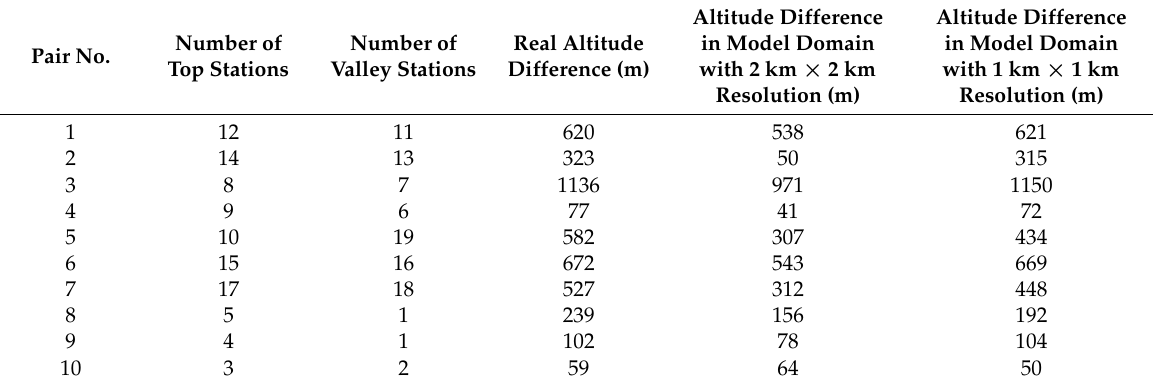
Table 6. Station pairs used for vertical temperature gradient